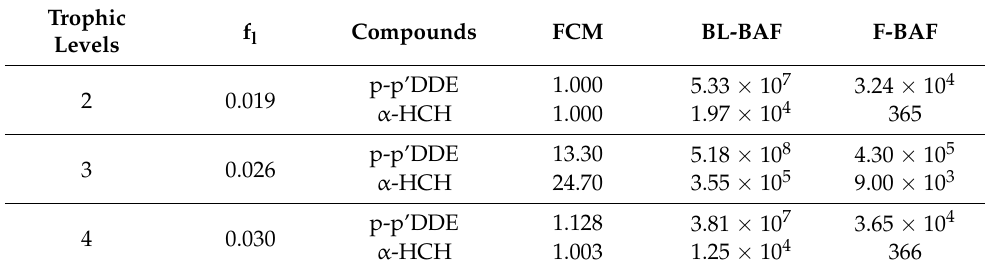
Table 3. Bioaccumulation factor parameters and calculated values.